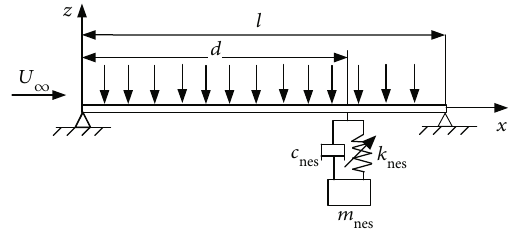
Figure 1: A 2D aeroelastic fl at panel model coupled with an